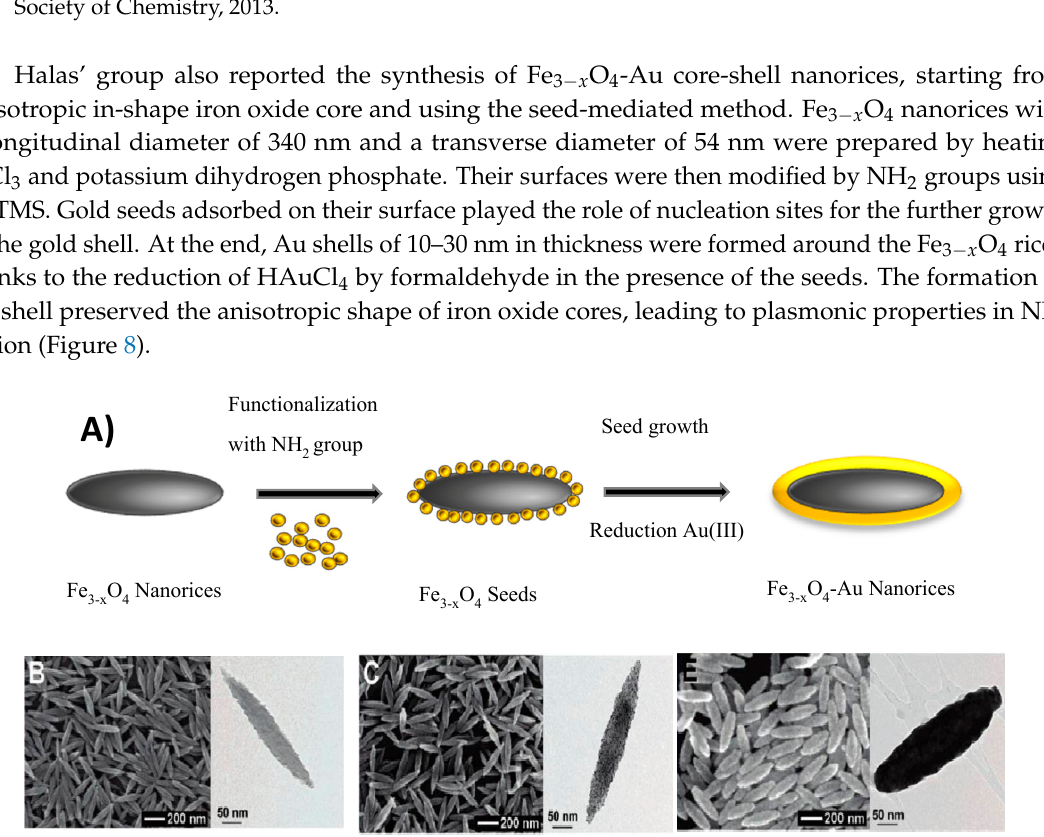
Figure 7. Schematic representation of the synthesis of Fe 3 O 4 -Au core–shell nanocubes, starting from monodisperse hydrophobic magnetic nanocrystals, coated with poly- L -histidine (PLH). The simultaneous addition of gold precursors and reducing reagents leads to the formation of a thin and continuous gold layer on the core nanocubes. Reproduced with permission from [59]. Royal